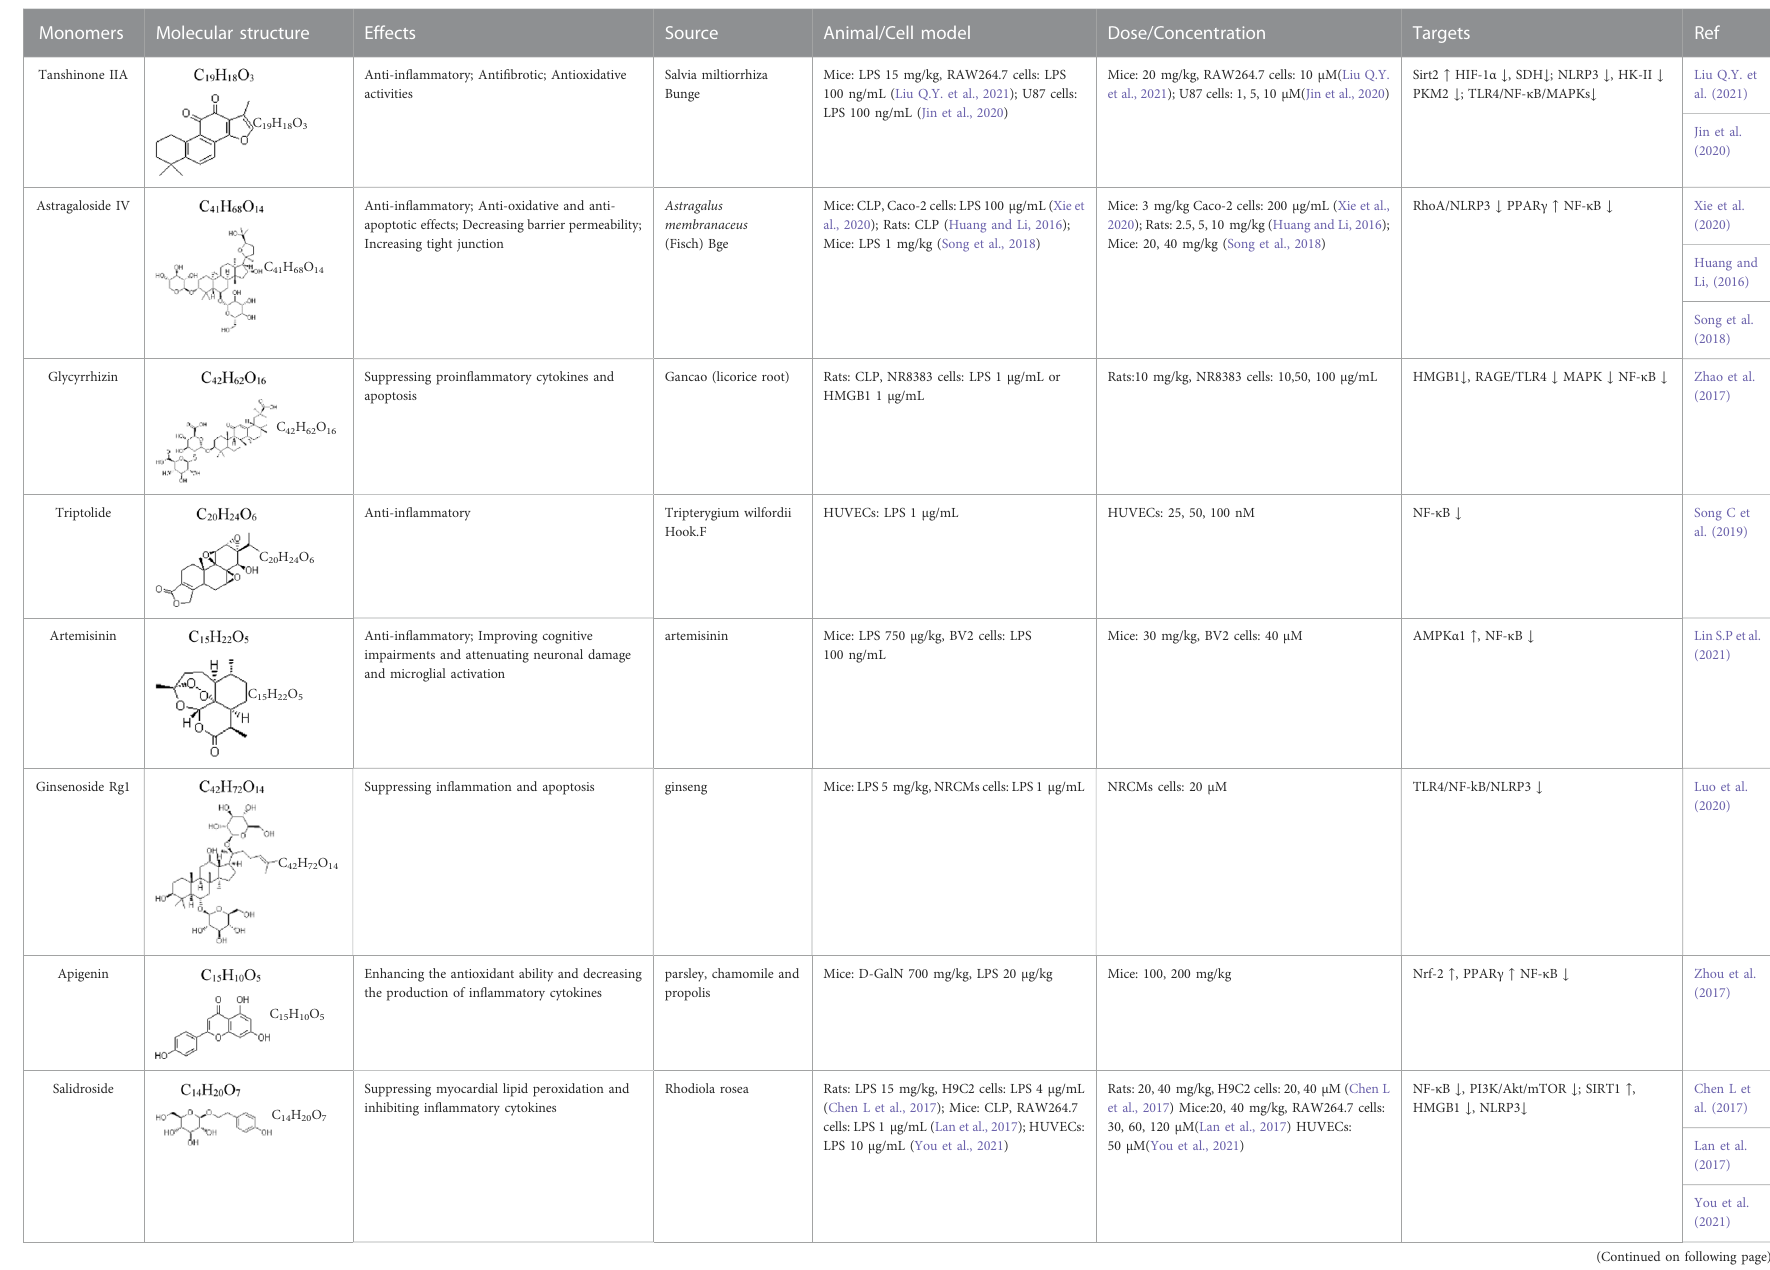
TABLE 2 Characteristics of TCM extracts/monomers on